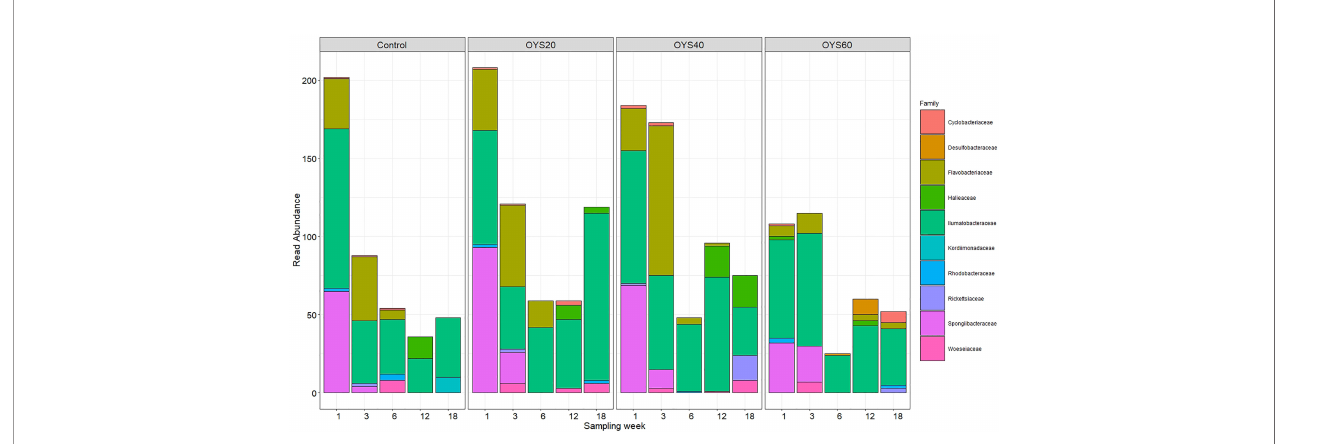
FIGURE 7 | Read abundance of putative bacterial plastic-degrading families per sampling weeks and